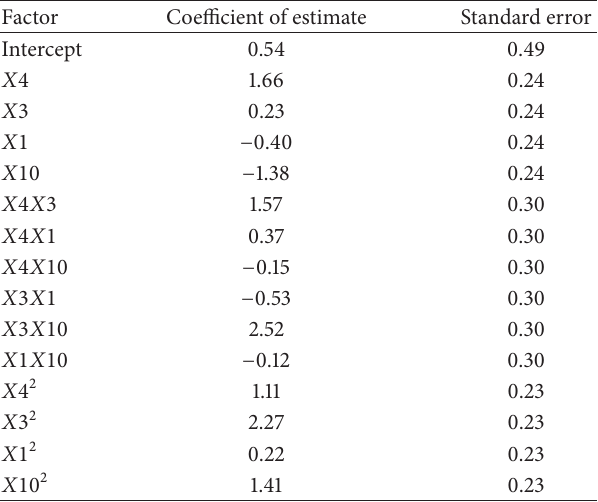
Table 7: Coefficients of the multivariate process models for the rifamycin B production from mediterranei MTCC.